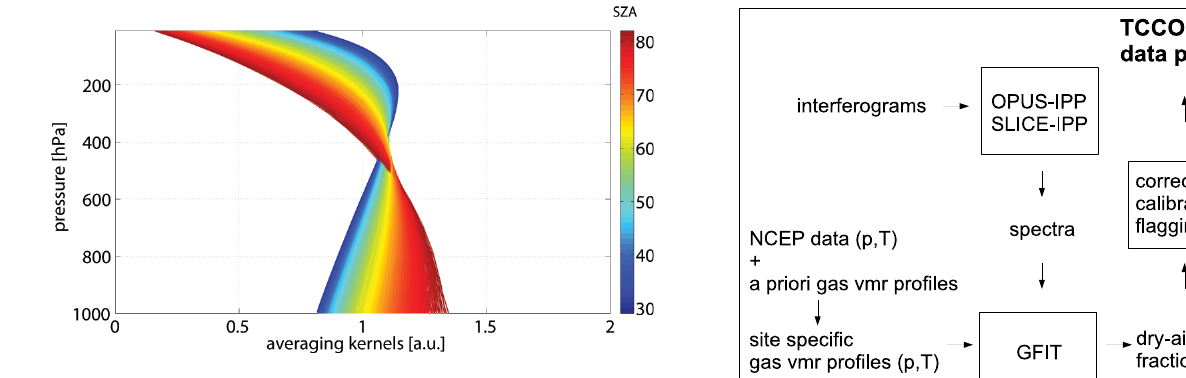
Fig. 3. CO 2 averaging kernels for the presented Białystok FTS mea- surements, color coded for different solar zenith angles (SZA). The averaging kernels have no distinct maximum and are constant to first approximation within the troposphere and vary primarily due to different solar zenith angles.